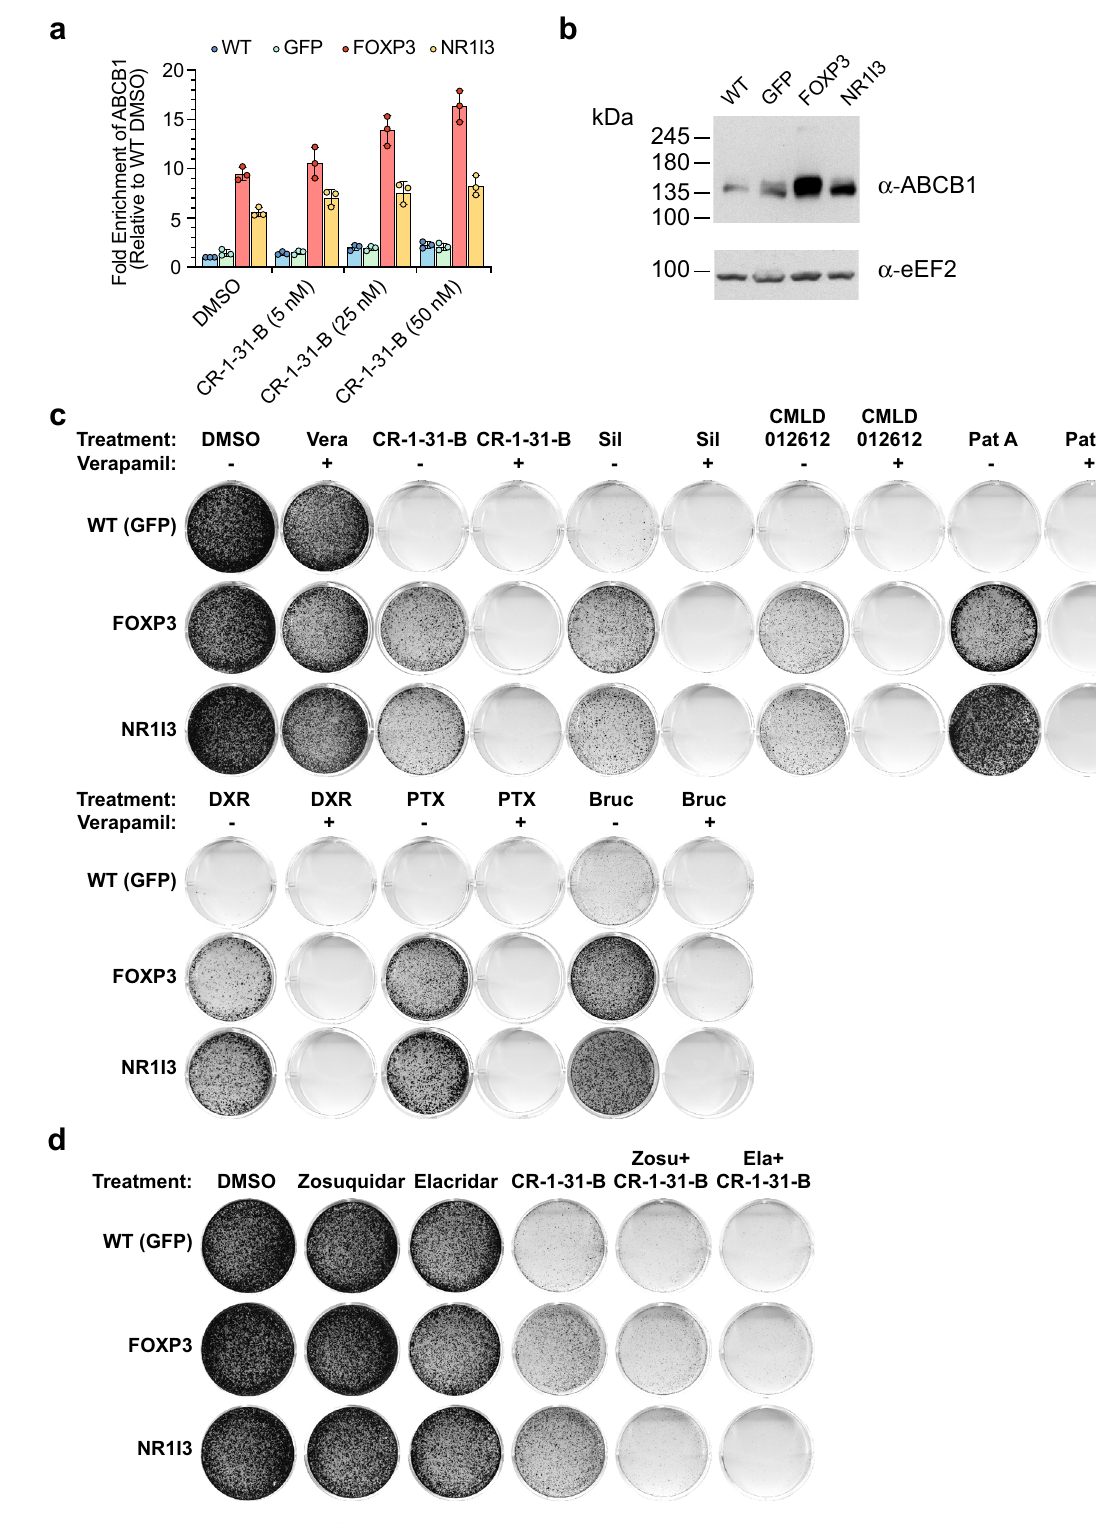
Figure 5. Inhibition of ABCB1 reverses the MDR phenotype in FOXP3- and NR1I3-expressing cells. ( a ) ABCB1 mRNA levels in wild-type (WT), GFP -, FOXP3 -, and NR1I3 -expressing Hap1 cells were measured by RT-qPCR across 4 conditions (DMSO, 5/25/50 nM CR-1-31-B for 6 h). n = 3 ± SD. ( b ) Western blot documenting ABCB1 expression in wild-type (WT), GFP-, FOXP3-, and NR1I3-expressing Hap1 cells. Uncropped scans are in Fig. S5. ( c ) Representative experiments from colony formation assays in Hap1 cells following compound treatment in the presence or absence of verapamil for 4–14 days. n ≥ 3. Compounds and concentrations were: 10 µM verapamil (Vera), 5 nM CR-1-31-B, 50 nM silvestrol (Sil), 10 nM CMLD012612 (012612), 1 nM Pat A, 12 ng/mL doxorubicin (DXR), 15 nM paclitaxel (PTX), 10 nM bruceantin (Bruc). ( d ) Representative experiments from colony formation assays in Hap1 cells following 5 nM CR-1-31-B treatment in the presence or absence of zosuquidar or elacridar for 4–14 days. n ≥